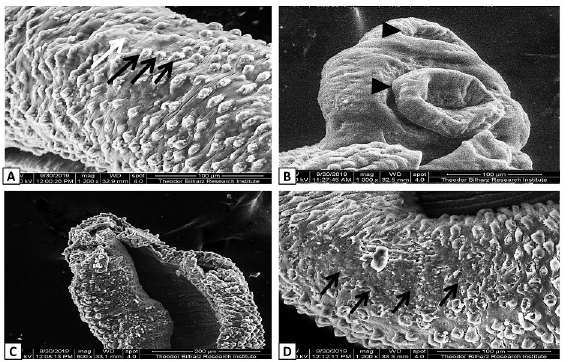
Fig 6. Scanning electron micrograph of dorsal surface of S . mansoni male worms recovered from A and B Ginger treated mice (G4) showing moderate distortion of the tubercles with short and blunt spines (black arrows), loss of intertubercular ridges (white arrow), and softening and flattening of oral and ventral suckers (black arrow head); C and D GNPs-treated mice (G5) showing extreme deformity and abnormal surface architecture in the form of flattened tubercles that lost their spines and appeared torn at the tip (black